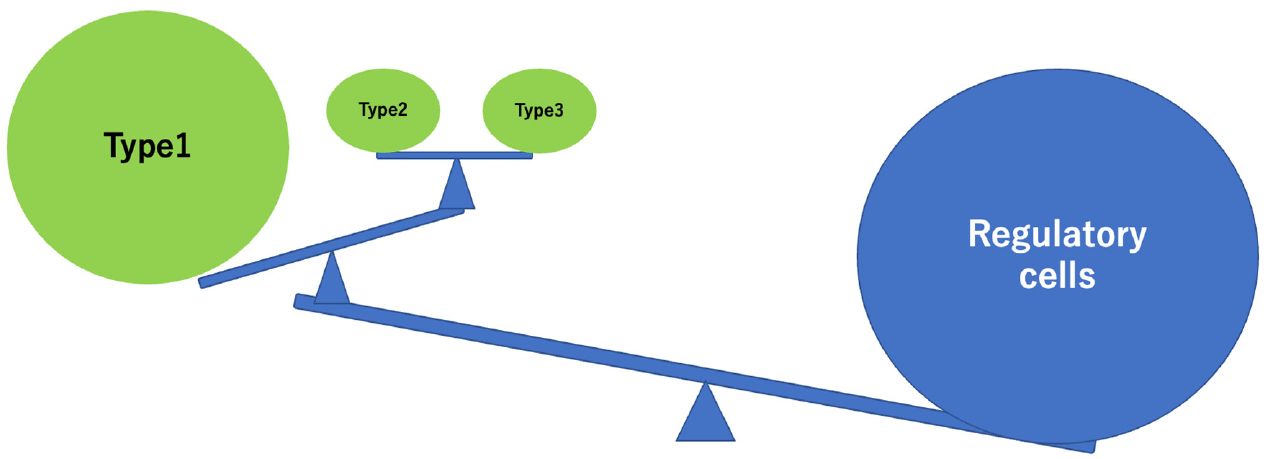
Figure 6. The immunological balance between four factors. Based on our analyses, this cartoon represents the balance between type 1, type 2, and type 3 immunity with respect to the regulatory cells in AD. The size of the rounds represents the abundance in the indicated cell types.